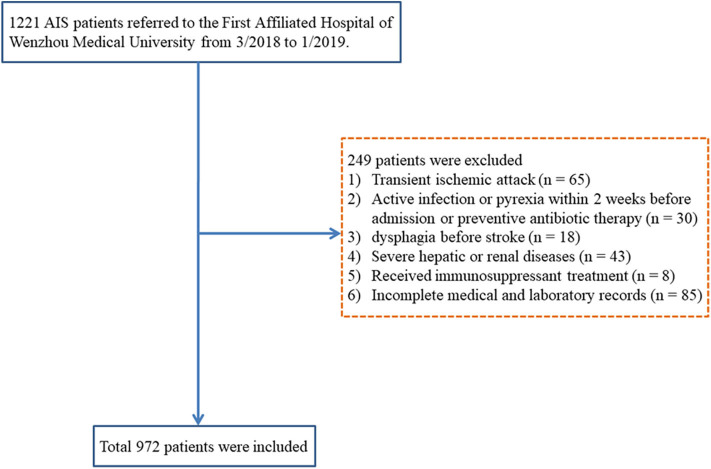
Research flowchart. AIS, acute ischemic stroke.